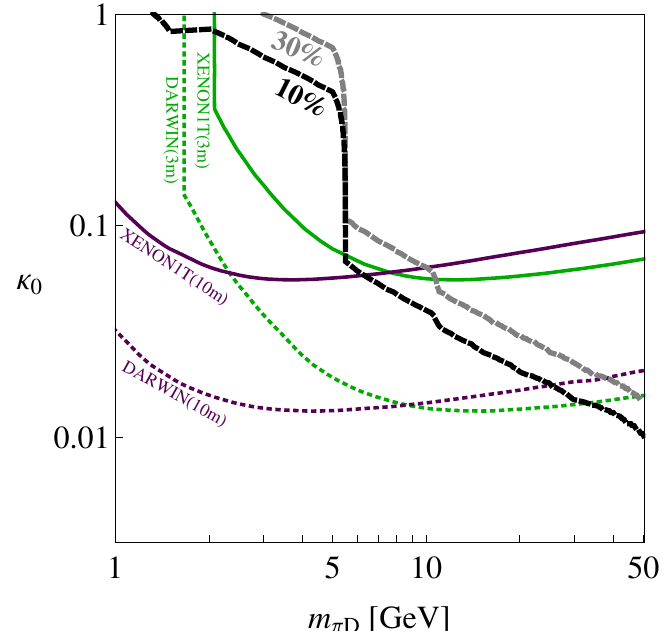
Figure 7. The thick black (grey) line delineates the region in which more than 10% (30%) of dark pions have decayed within 1m transverse distance from the beamline at the 14 TeV LHC. Overlaid are current (solid) and projected (dashed) dark matter direct detection bounds, assuming a dark proton mass of 3 m (cid:25) (green) or 10 m (cid:25) (purple). This parameter space corresponds to the D D \aligned" scenario, (cid:20) = (cid:20) 0 1 3 3 , and choosing m X = 1 TeV, f D = m (cid:25) D (cid:2)